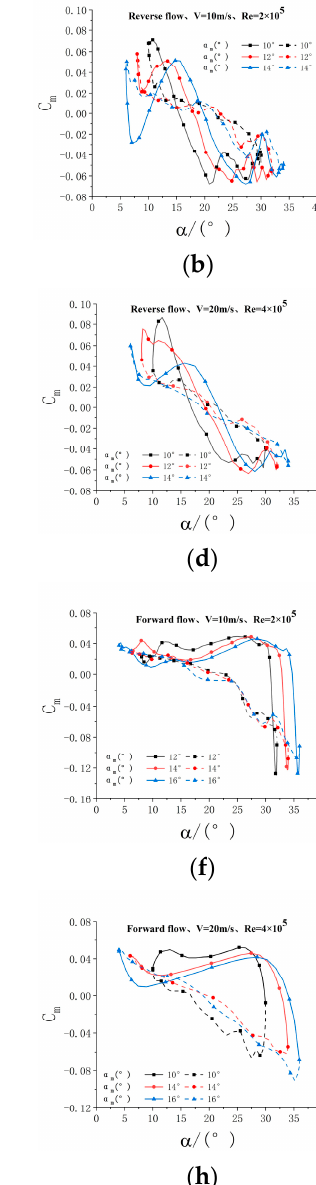
( f ) Figure 16. Effect of the oscillation amplitude at different reduced frequencies. ( a ) K = 0.08, C L , ( b ) K = 0.08, C m , ( c ) K = 0.10, C L , ( d ) K = 0.10, C m , ( e ) K = 0.12, C L , ( f ) K = 0.12, C m . It can be seen that in the reverse flow region, the alternating moment of the airfoil is pronounced; the greater the pitch amplitude, the more notable the alternating moment. Under different reduced frequencies, the mean angle of attack has the same influence on the dynamic stall during forward and reverse-blowing states. The increase of the mean angle of attack delays the occurrence of dynamic stall, and the maximum lift coefficient increases accordingly. In the case of reverse-blowing, during the upward phase of the pitching motion of the airfoil, the lift coefficient decreases slowly after the occurrence of dynamic stall; there are two peaks in the lift coefficient curve, indicating that a secondary stall has occurred. The lift coefficient recovers slowly in the downward phase of the pitching motion of the airfoil until the minimum angle of attack is reached, and the lift coefficient is far less than that in the ascending stage. This means that the airflow on the airfoil surface is always separated during the downward phase of the airfoil. In the case of forward-blowing, the lift coefficient in the downward phase of airfoil pitching is always smaller than that in the upward phase, and the airflow is not adsorbed on the airfoil surface again. 3.3.2. Effect of the Oscillation Amplitude at Different Reynolds Numbers During the experiment, the mean angle of attack was kept constant, and the oscilla-